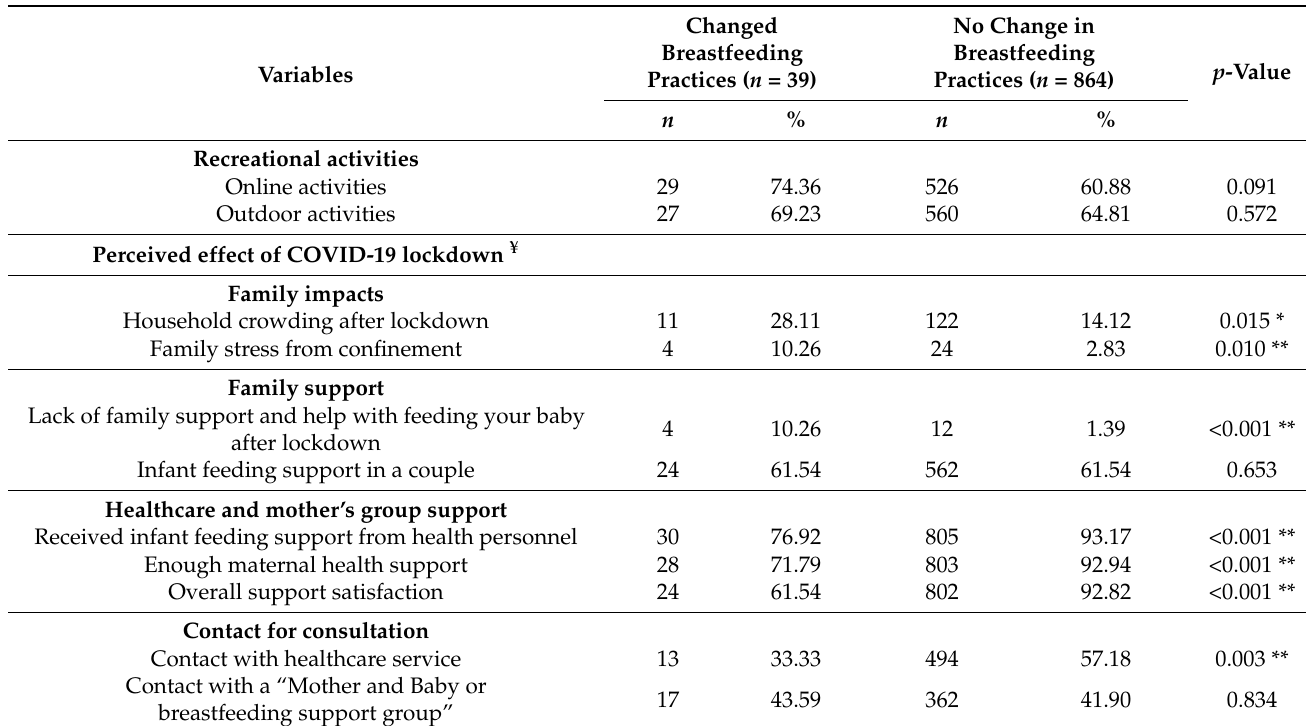
Table 2. Comparison of recreational activities and perceived effects of lockdown between mothers who had changed and not changed breastfeeding practices during the COVID-19 lockdown.